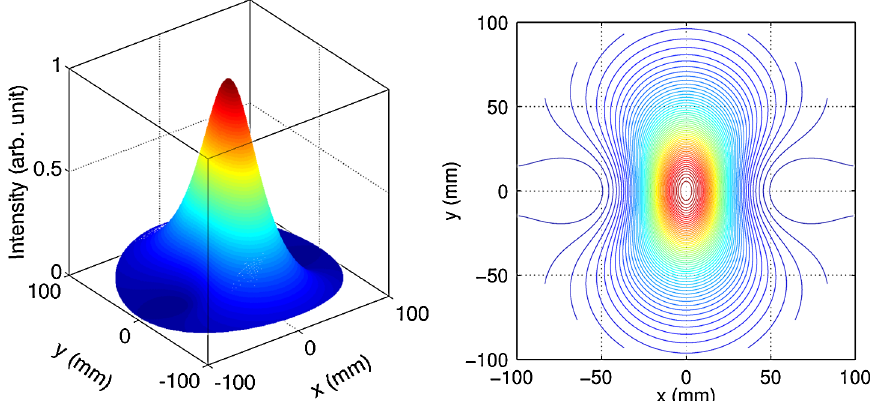
FIG. 5. The computed spatial distribution of Compton gamma-ray photons produced by a head-on collision of a linearly polarized 800 nm laser beam with an unpolarized 500 MeVelectron beam. The polarization of the incident photon beam is along the horizontal direction. The distribution is calculated for a location 60 meters downstream from the collision point. The left plot is a three-dimensional intensity distribution, and the right plot is the contour plot of the gamma-beam intensity